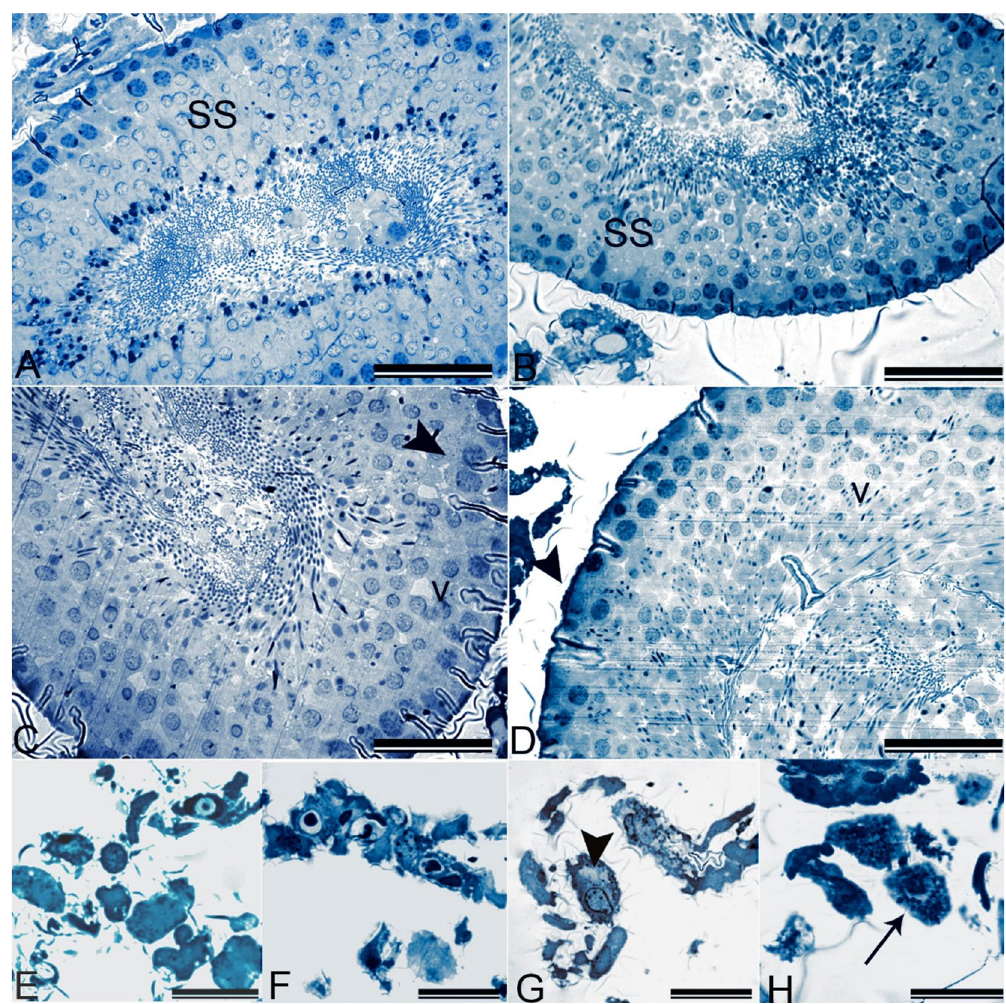
Figure 4. ( A–D ) High magnification of seminiferous tubules and interstitial cells in control and olanzapine administrated animals. ( A ) Control: Normal aspect of the seminiferous tubules containing regular cells of the spermatogenic series (SS) ( B ) OLZ-2.5: No observable pathology in spermatogenic series (SS). ( C ) OLZ-5: Swelling of spermatogenic cells (arrowhead) and mild intercellular vacuolation (v). ( D ) OLZ-10: Increased intercellular vacuolation (v), decreased sperm count and thickening of the basement membrane (arrowhead). 700 nm sections stained with toluidine blue. Scale Bar:50 µm. (E – H) High magnification of Leydig cells in control and olanzapine administrated animals. ( E ) Control: Normal appearance of Leydig cells ( F ) OLZ-2.5:No observable pathology in Leydig cells. ( G ) OLZ-5: Vacuolation (arrowhead) in Leydig cells. ( H ) OLZ-10: Swelling and increase in lipofuscin granules in Leydig cells (arrow). 700 nm sections stained with toluidine blue. Scale Bar:20